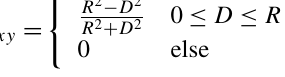
Fig. 3 in the form of a box plot. The circle corresponds to the median, the colored box indicates the 25th and 75th per- centile, and the whiskers to both sides mark ± 2 . 7 times the standard deviation ( σ ). Outliers beyond ± 2 . 7 σ are hidden to maintain clarity and readability. The continuous line in Fig. 3a represents the root mean square error between the measured U lidar and simulated wind speed U WRF .